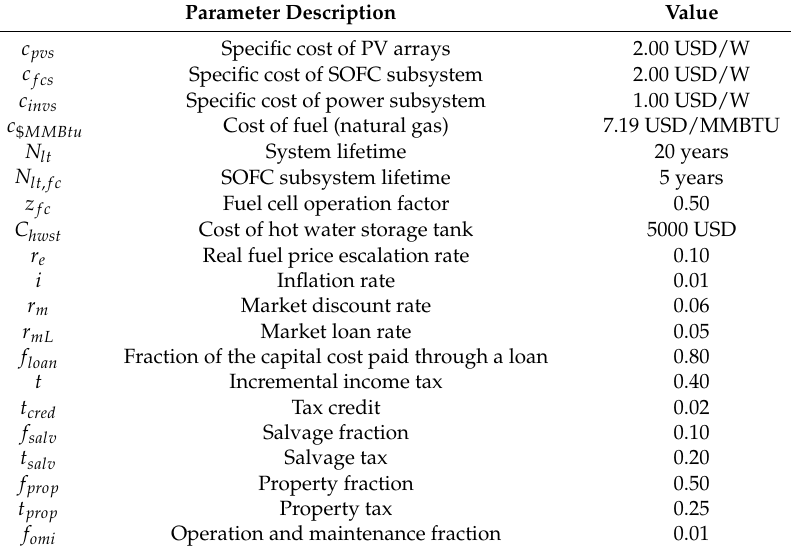
Table 3. Parameters held constant in the cost